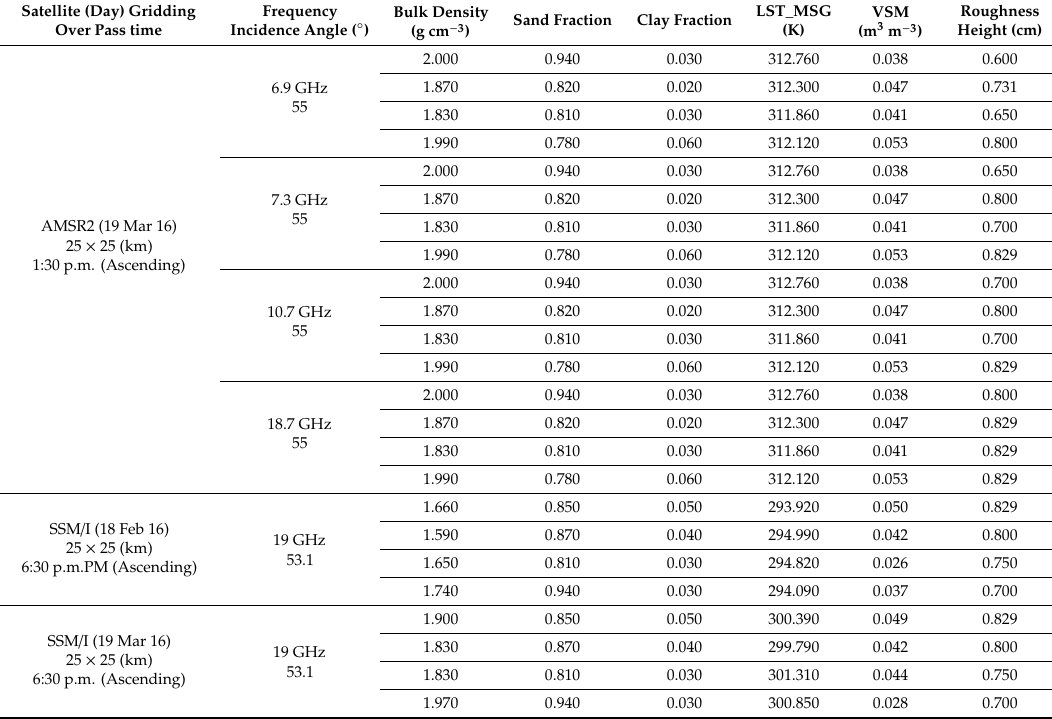
Satellite (Day) Gridding Over Pass